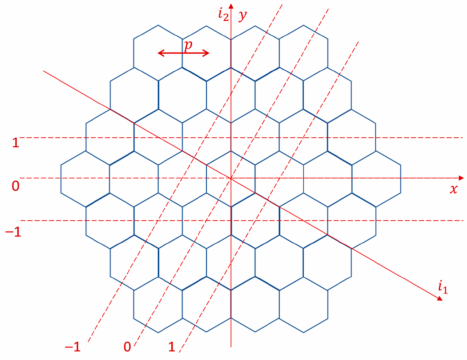
Figure 1. Hexagonal grid geometry